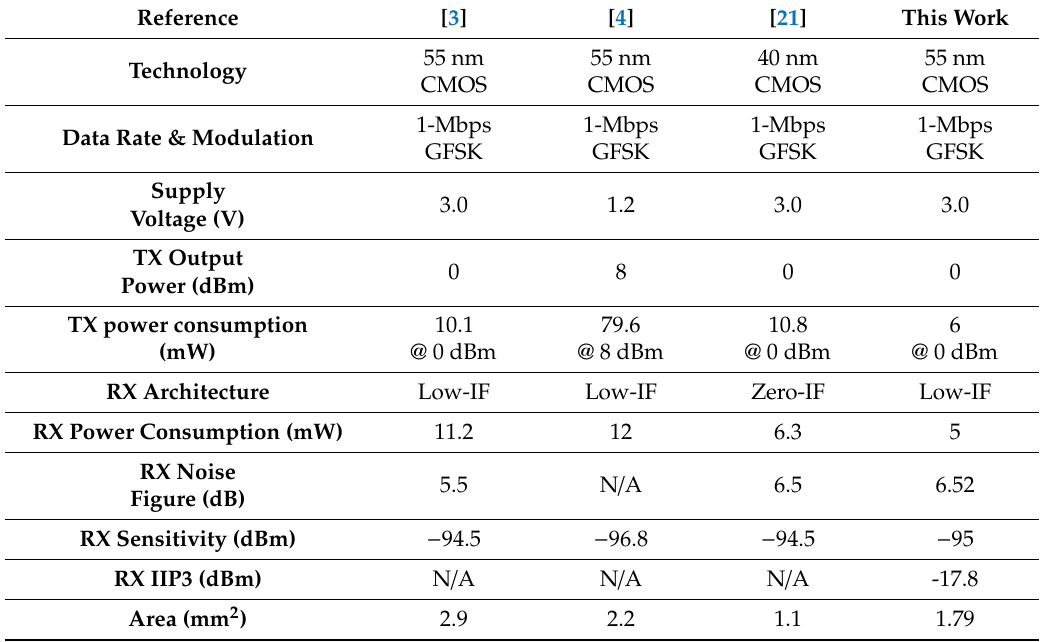
Table 2. Performance